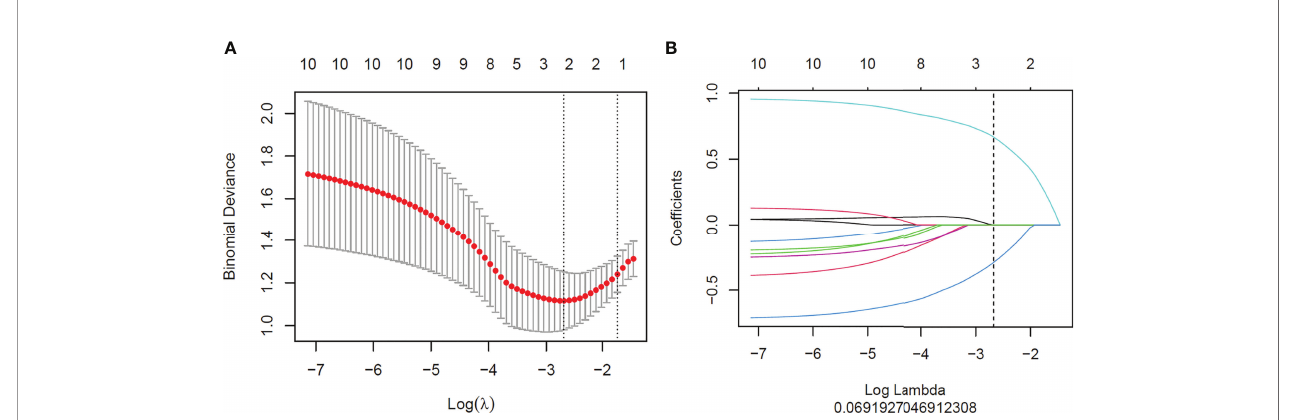
FIGURE 3 | Feature selection with the least absolute shrinkage and selection operator (LASSO) binary logistic regression model. (A) Tuning parameter ( l ) selection of the LASSO model. Binomial deviance was drawn versus log( l ). Vertical dotted lines were plotted at the best value using 10-fold cross-validation to tune parameter ( l ) selection in the LASSO model. (B) LASSO coef fi cient pro fi les of the features. Each colored line represents the corresponding coef fi cient of each feature. A vertical dotted line was drawn at the selected l , where non-zero coef fi cients were obtained with two